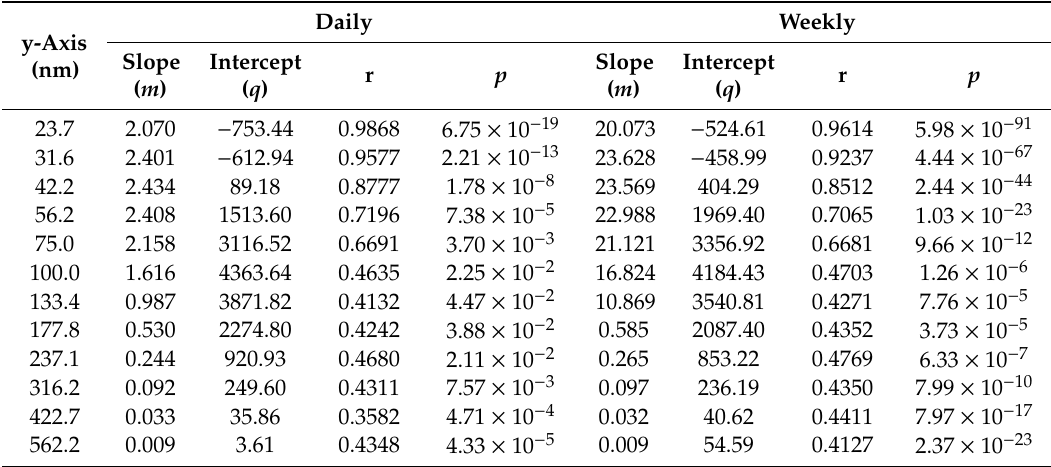
Table 3. Linear correlations between particles in the 17.8 nm-size fraction (x-axis) and particles in each other size fraction (y-axis) both during a typical day and during a typical